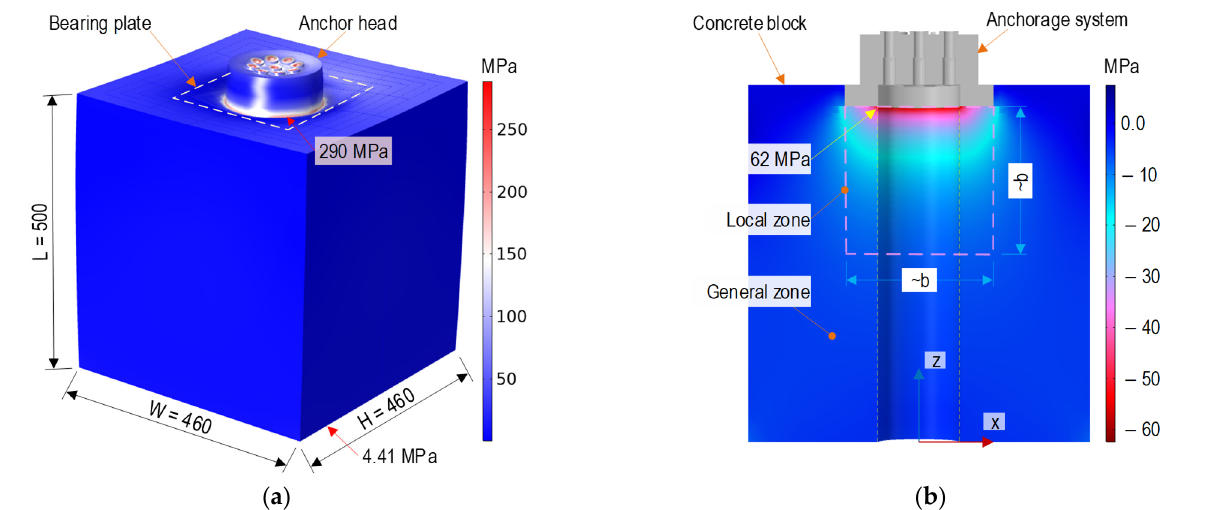
Figure 2. Stress distribution in prestressed anchorage zone subjected to applied force, PS: ( a ) von Mises stress; ( b ) Axial